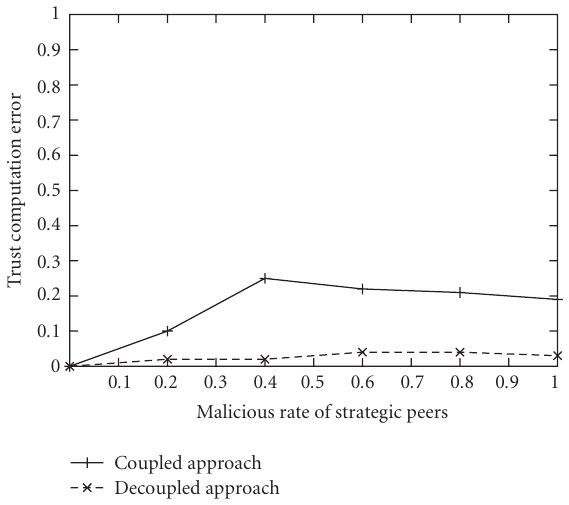
Figure 10: Trust computation error in a network with a varying malicious rate of strategic